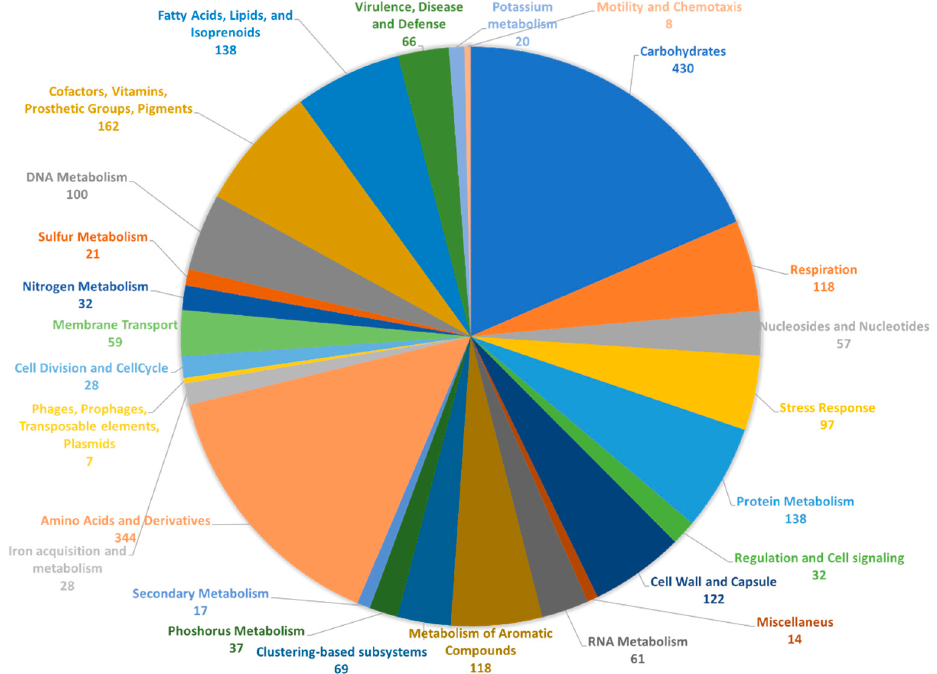
Figure 1. Overview of functional categories assigned to predicted genes from Rhodococcus sp. I2R. The whole-genome sequence of the strain I2R was annotated using RAST. The number of genes assigned to each category is indicated.